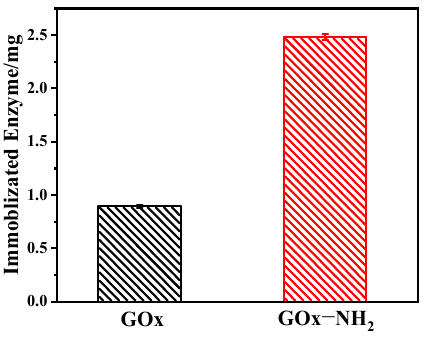
Figure 1. Adsorption capacity of unmodified GOx (black) and aminated GOx (red) on OMC-COOH. The free GOx-NH 2 kept 87.23% of its activity compared to the free unmodified GOx, indicating that after the chemical reactions to add the aminated groups, the glucose oxidase maintained its activity well. Since the ion bridge may be slightly destroyed and changed by the repulsive force, the modification can decrease the activity of the enzyme to a certain extent [45]. In addition, Table 1 shows that although chemical amination made the unit enzyme activity low, the total enzyme amount adsorbed by the material increased significantly—the total enzyme amount of GOx-NH 2 immobilized on OMC-COOH